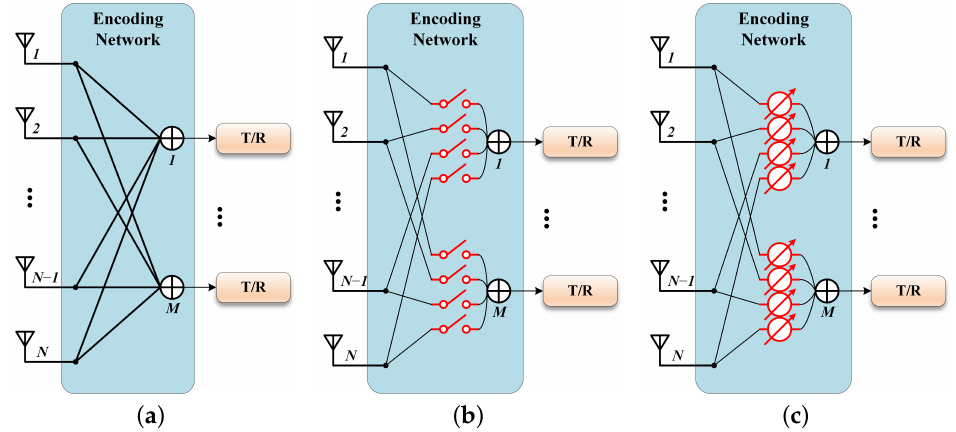
Figure 2. Different encoding networks. ( a ) Fixed encoding network. ( b ) Tunable encoding network with RF switches. ( c ) Tunable encoding network with phase